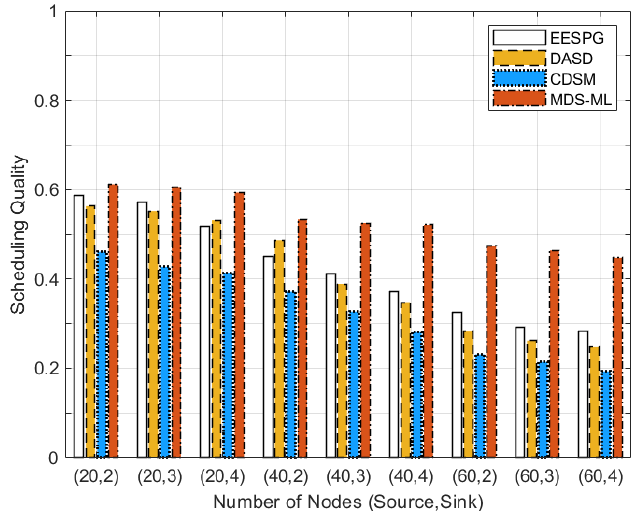
Figure 10. Comparison of scheduling quality with different number of nodes.